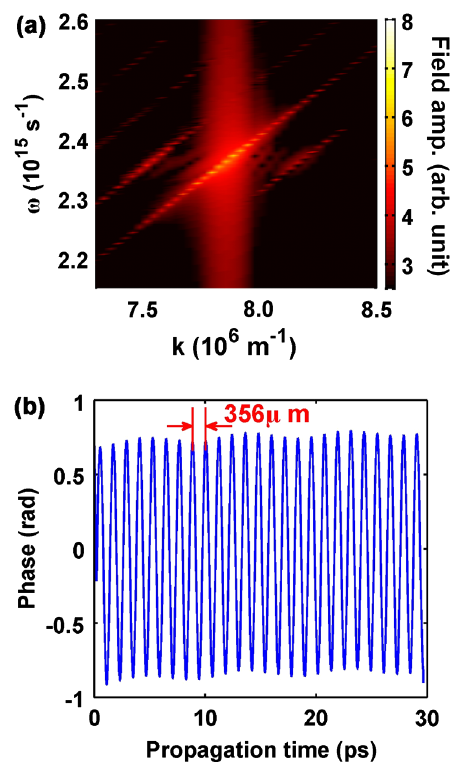
FIG. 1. (a) Fourier transform of the longitudinal electric field ) in time ( t ) and space ( z ) at a laser wavelength (cid:5) ( E z 800 nm , normalized vector potential a period d ¼ 20 (cid:7) m , and modulation amplitude (cid:1) ¼ 0 : 9 . The diagonal lines represent the spatial harmonics. The fundamental spatial harmonic is the central diagonal line. The diagonals to the left and right of the fundamental are (cid:9) 1st spatial harmonics, respectively. (b) Phase of the on-axis longitudinal electric field at a fixed (cid:6) point. The period of the phase oscillation corresponds to the density modulation